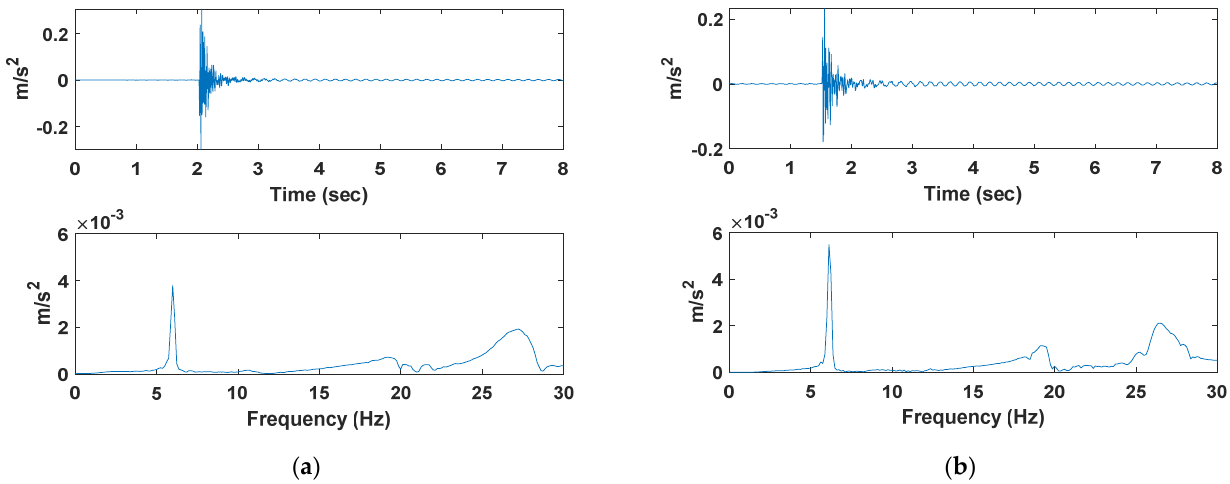
Figure 5. Hammering test results to measure the natural frequencies of the tower: ( a ) time series (top) and its frequency spectrum (bottom) in the east—west direction; ( b ) time series (top) and its frequency spectrum (bottom) in the south—north direction.